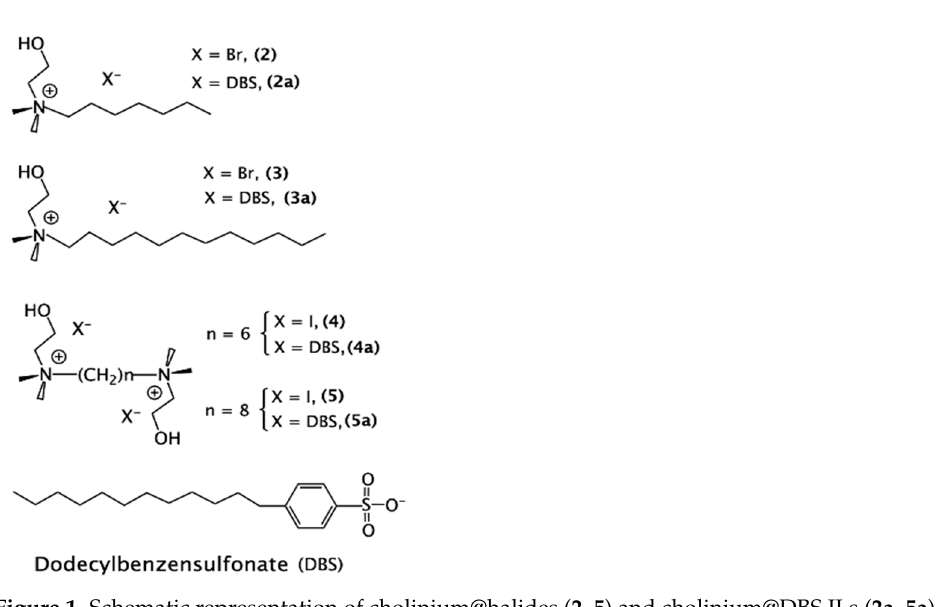
Figure 1. Schematic representation of cholinium@halides ( 2 – 5 ) and cholinium@DBS ILs ( 2a – 5a ).